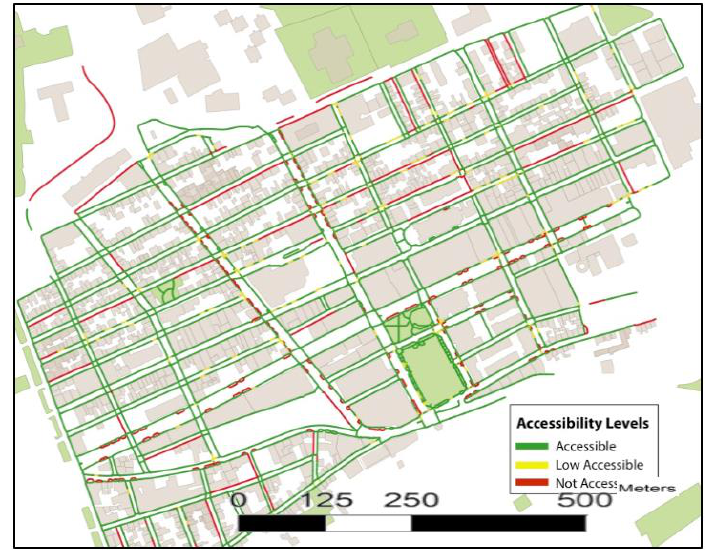
Figure 5. Accessibility map for Saint Roch, Quebec City based on 127 wheelchair users.